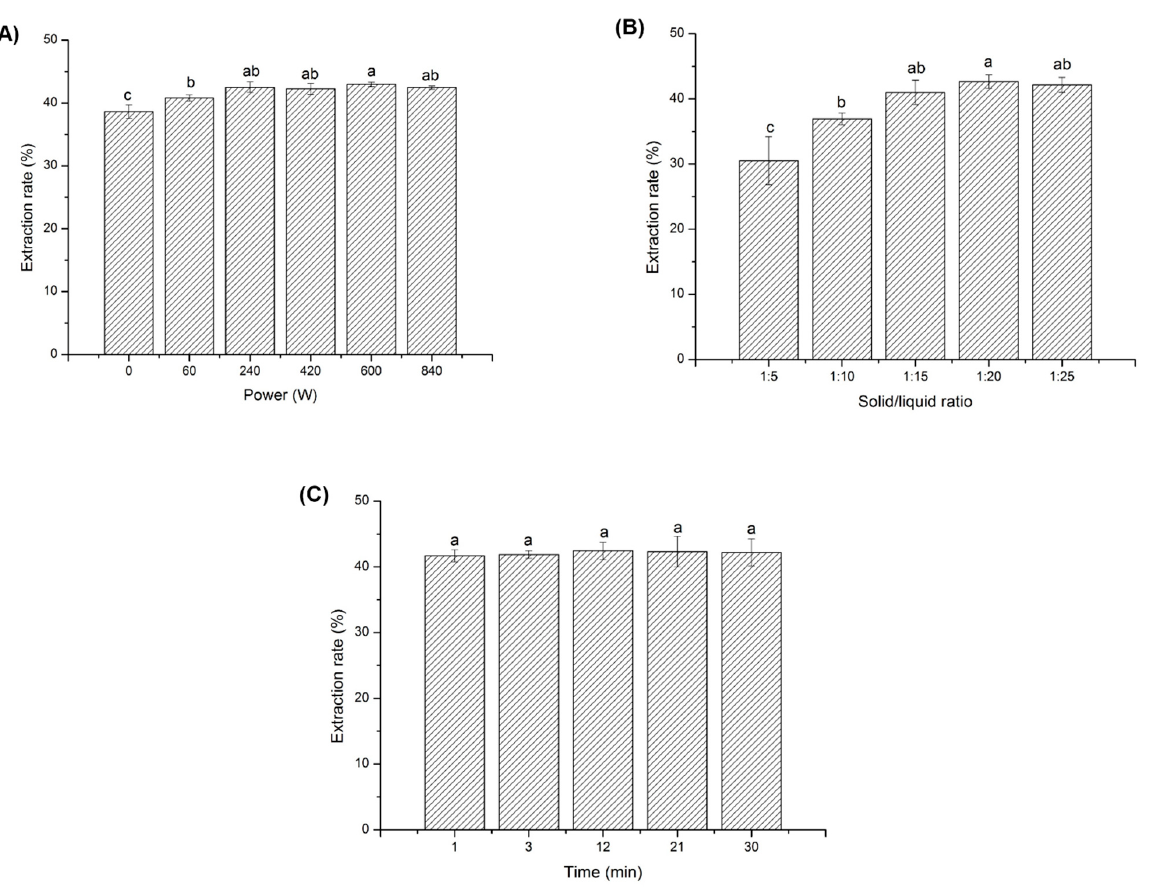
Figure 3. Single factor effect on the extraction rate of ultrasound-assisted extraction of Litsea cubeba kernel oils: ( A ) ultrasonic power, ( B ) solid–liquid ratio, and ( C ) extraction time. Columns marked by the same letter are not significantly at p < 0.05.